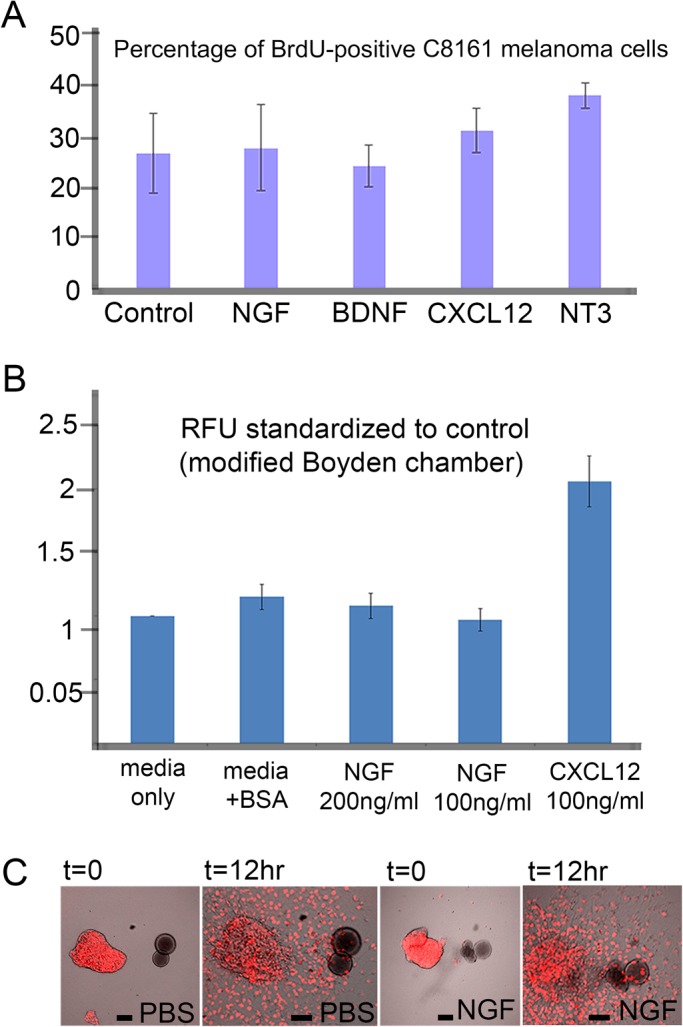
NGF does not affect proliferation or migration of C8161 melanoma cells. (A) Percentage of BrdU-positive C8161 melanoma cells under different co-culture conditions with various soluble factors (Control, no factor 26.9±7.86 cells, s.d.; NGF, 28±8.6 cells, s.d., P=0.5; BDNF, 24.4±4.17 cells, s.d., P=0.6; CXCL12, 31.5±4.42 cells, s.d., P=0.4; NT3, 38.4±2.5, s.d., P=0.07). Experiment was repeated in triplicate. (B) C8161 melanoma cells seeded into a modified Boyden chamber show no preference for BSA control (1.15±0.1 s.d., RFU) or NGF (200 mg/ml with 1.08±0.1 s.d., RFU, P=0.4 and 100 ng/ml with 0.97±0.09 s.d., RFU, P=0.2), but migrate in response to a known chemokine, CXCL12 (2.06±0.2 s.d., RFU, P<0.01). Experiment was repeated in duplicate. (C) PBS- or NGF-soaked beads co-cultured in vitro with C8161 melanoma cells (labeled with H2B-mCherry, red) and observed at t=0 and 12 h show no directed cell migration towards either the PBS- or NGF-soaked beads, n=4 bead cultures per condition, repeated in triplicate. Scale bars: 100 μm (t=0) and 50 μm (t=12 h). All calculations performed on living samples. Statistically analysis was performed using Student's t-test.